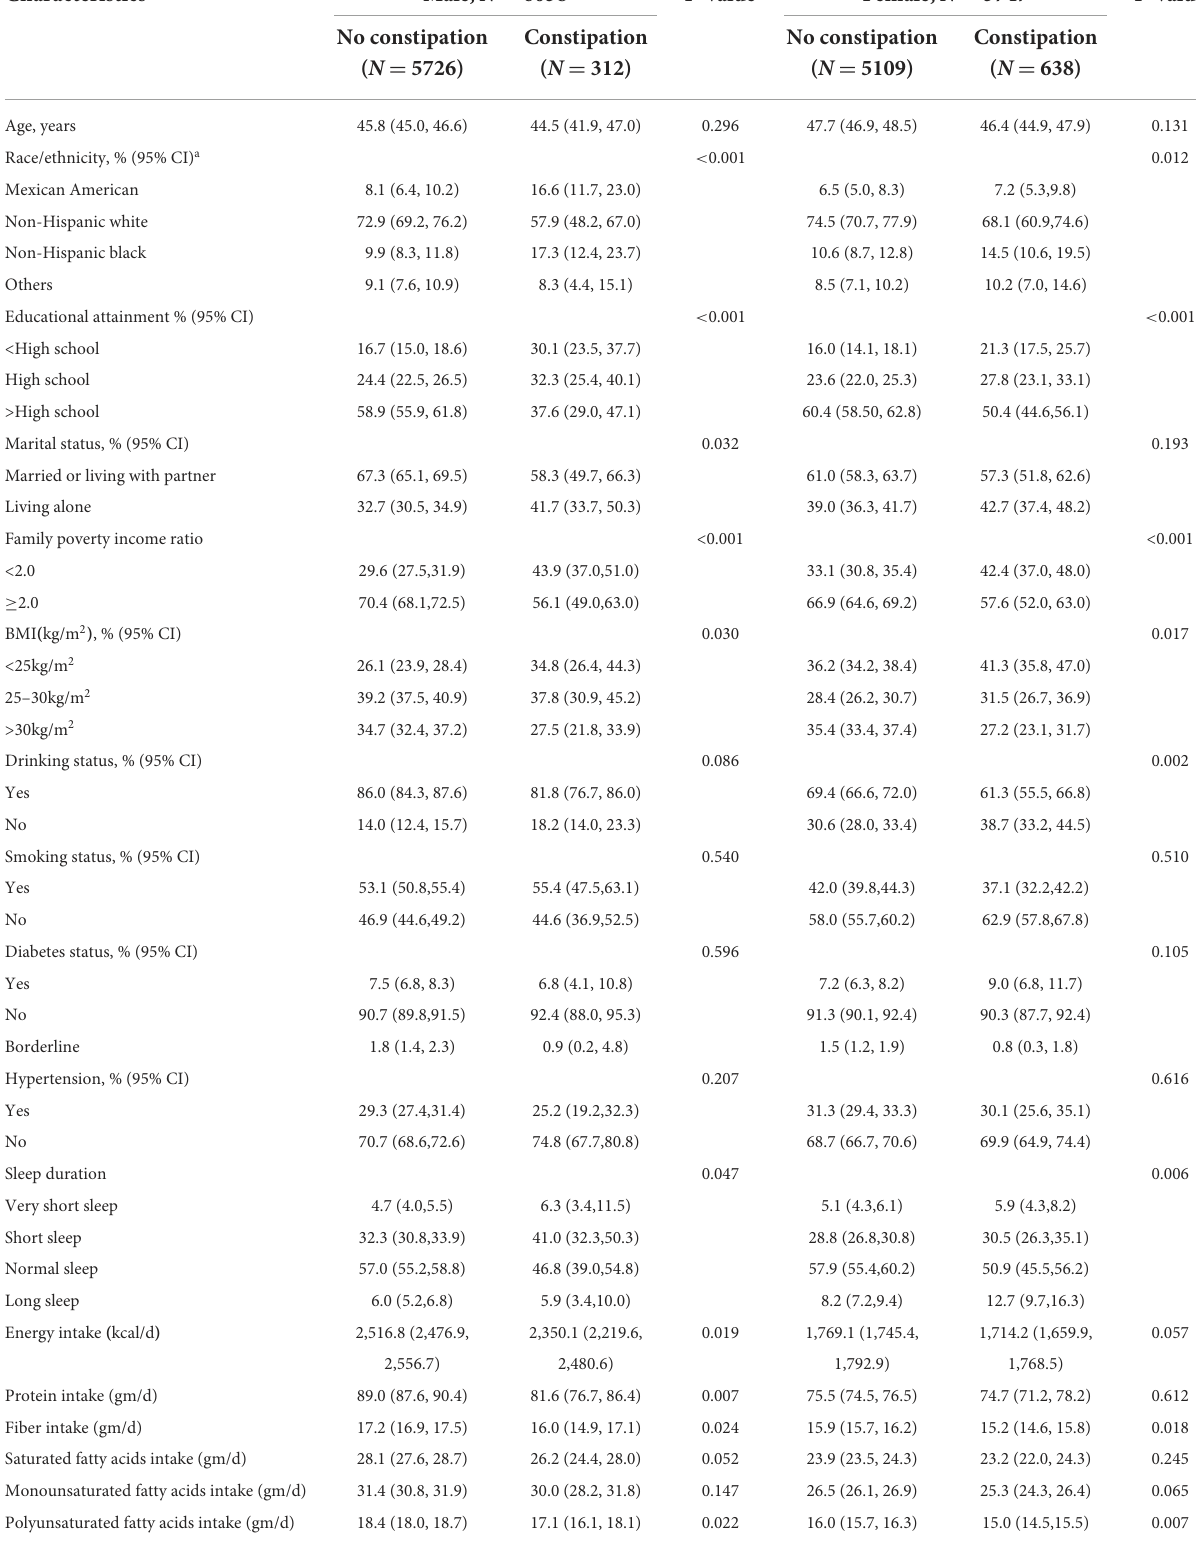
TABLE 1 Participant characteristics by constipation among men and women from NHANES 2005–2010.